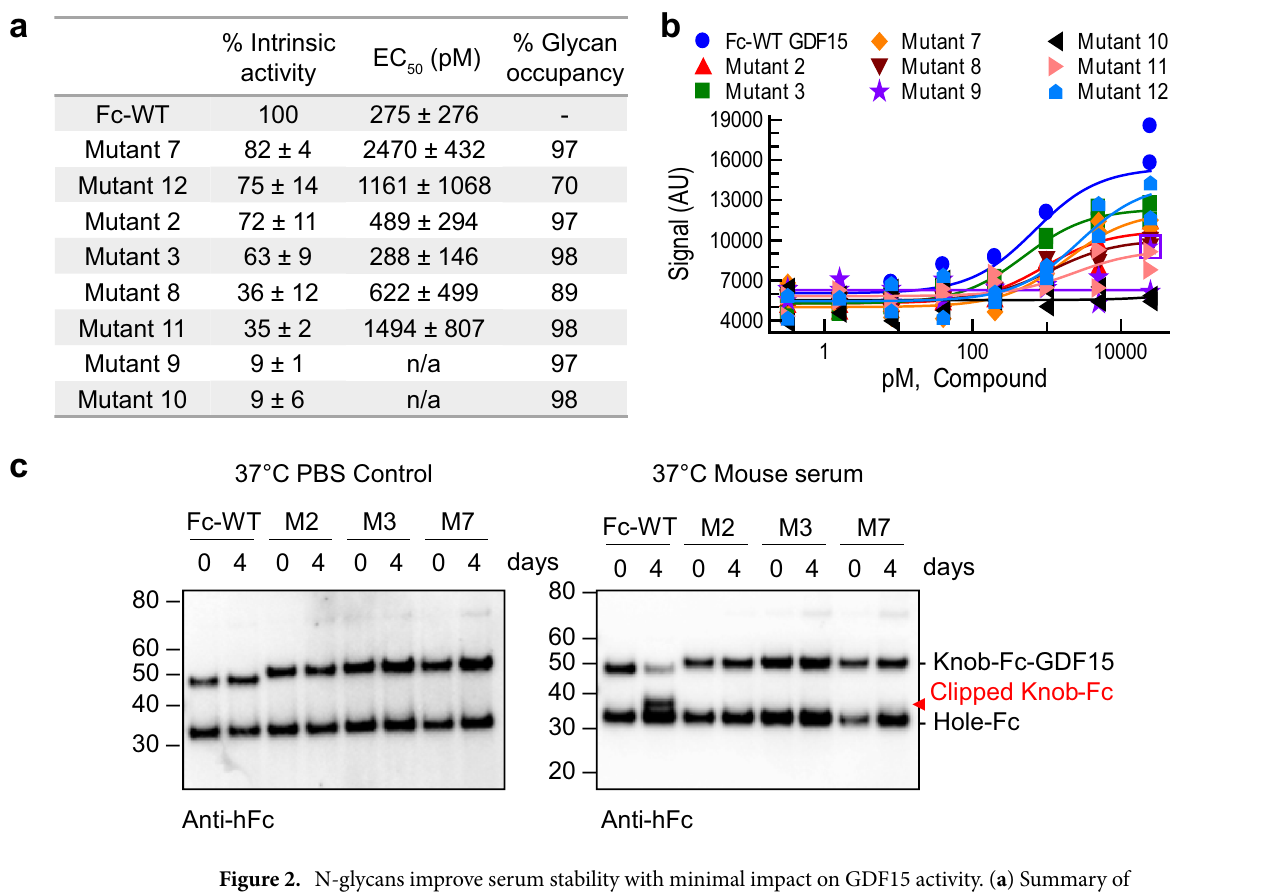
Figure 2. N-glycans improve serum stability with minimal impact on GDF15 activity. ( a ) Summary of Fc-GDF15 functional activity and glycan occupancy, from highest intrinsic activity to lowest. Functional activity was measured by Phospho-ERK HTRF (Homogeneous Time Resolved Fluorescence) assay and reported as EC 50 and % intrinsic activity (maximum response, Ymax) normalized to wildtype Fc-GDF15 (Fc-WT). Data are reported as mean ± SD. N = 4. EC 50 values of “n/a” indicate that EC 50 could not be determined due to low activity. Glycan occupancy at engineered NxT sites was measured using capillary gel electrophoresis. ( b ) Representative data from p-ERK assay summarized in ( a ). N = 4. The Y-axis values represent the HTRF signal ratio (665/615 nm × 10 4 ). ( c ) In vitro serum stability of wildtype Fc-GDF15 control (Fc-WT), Mutant 2, Mutant 3, and Mutant 7 following 4 days of incubation in mouse serum or a PBS control at 37 °C. Gross clipping was detected by Western blot using an anti-human Fc antibody. Clipped chain highlighted in red. Full length blots are presented in Supplementary Fig.